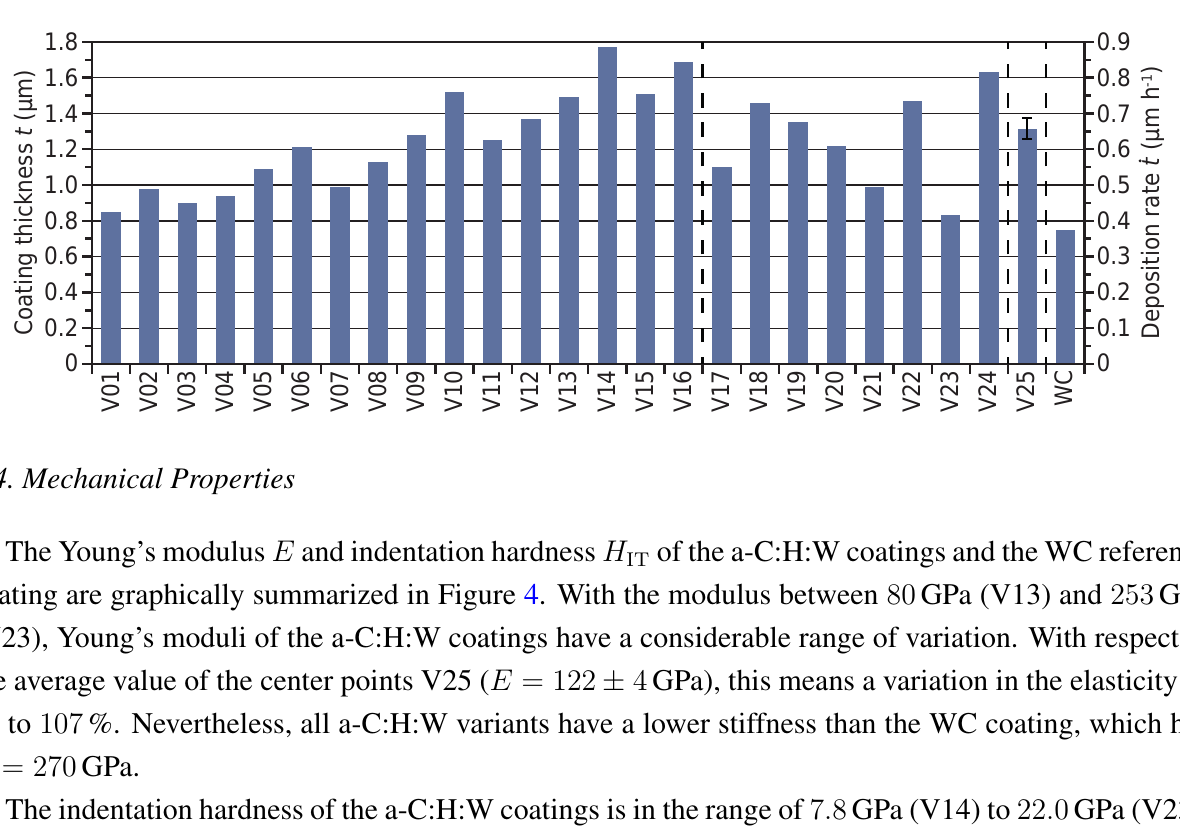
Figure 3. Coating thickness t and deposition rate ˙ t of the a-C:H:W variants and the WC coating. Due to the constant deposition time, t and ˙ t are directly